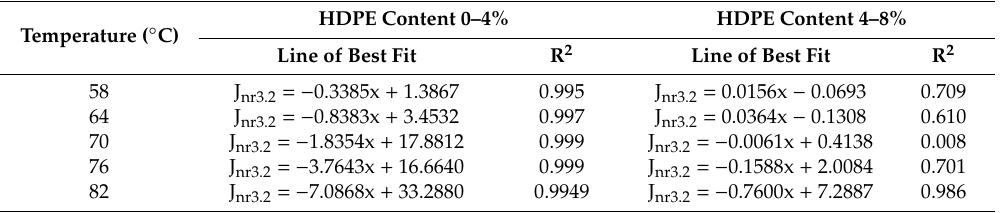
Figure 9. The correlation of Jnr (non-recoverable compliance and waste HDPE content. Table 4. Data analysis and liner regression between waste HDPE content and the non-Recoverable Compliance.